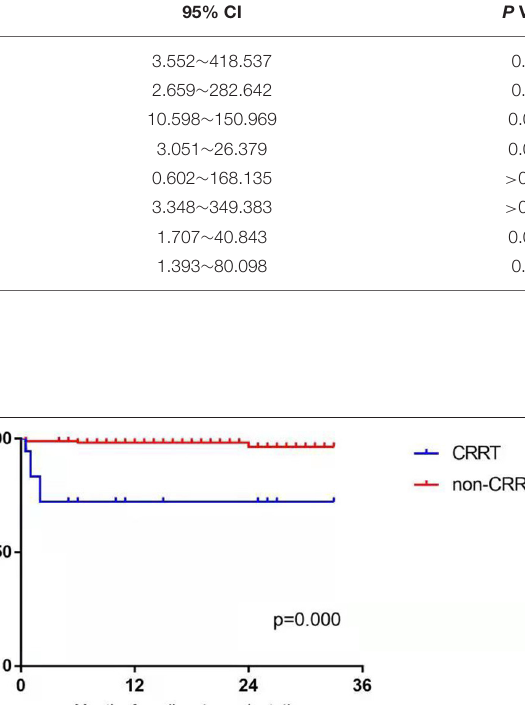
TABLE 4 | Results of multivariate logistic regression analysis of CRRT-related factors. Variable